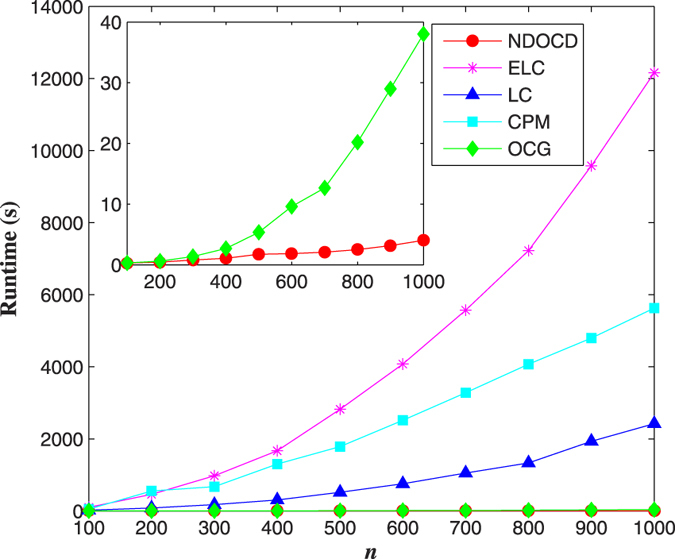
Comparison of computation time of different algorithms on synthetic networks with different sizes.Plots show runtime (s) for networks with n = 100 ~ 1000, k = 10, kmax = 50, u = 0.1, τ1 = 2, τ2 = 1, cmax = 50, cmin = 10, om = 2, on/n = 10%.